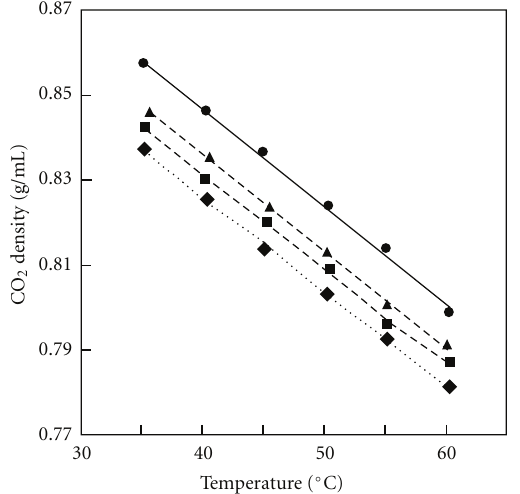
Figure 1: Plots of the experimental cloud points of the copolymers with POA/AA of 6/4 ( • ), 7/3 ( (cid:2) ), 8/2 ( (cid:3) ) , and 9/1 ( (cid:4) ) at each temperature versus the CO 2